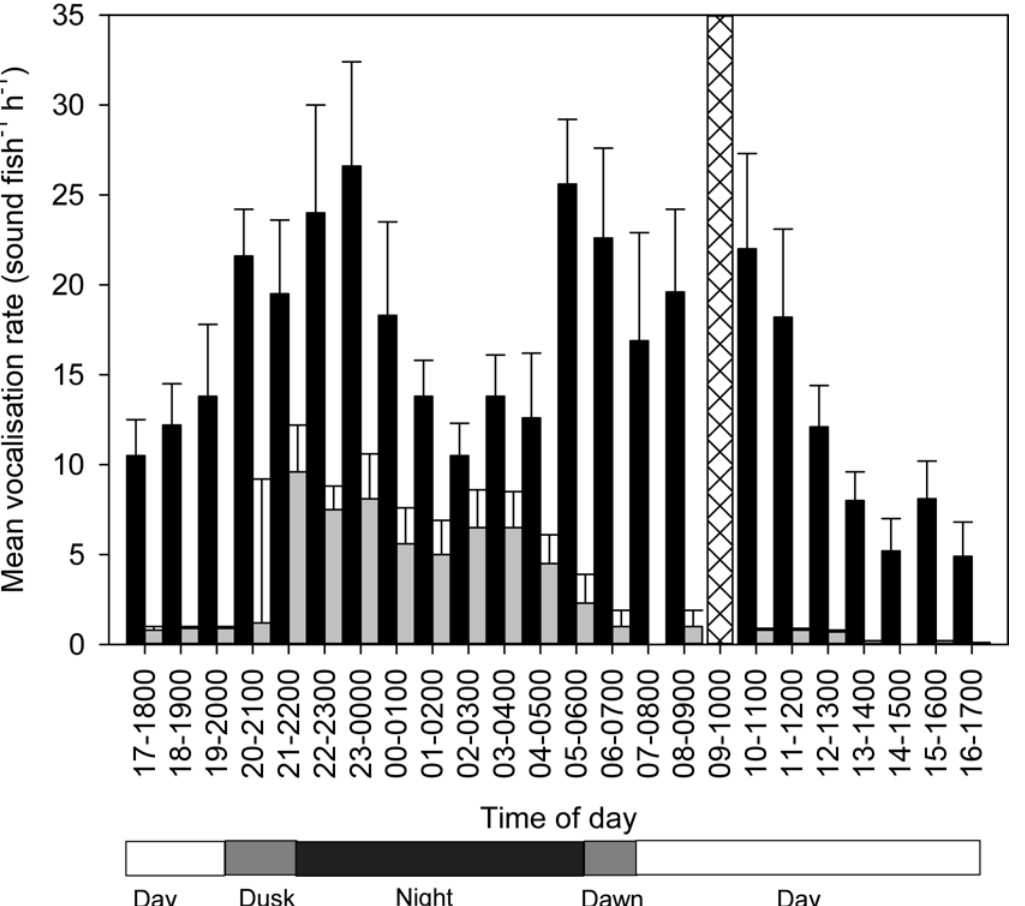
Fig 4. Daily pattern of vocal activity showing mean hourly vocalisation rate (mean ± SEM; n = 5). Black bar represents grunt sounds and grey bar represents growl sounds. The single shaded vertical bar at 0900 – 1000 hrs indicates the activation of water